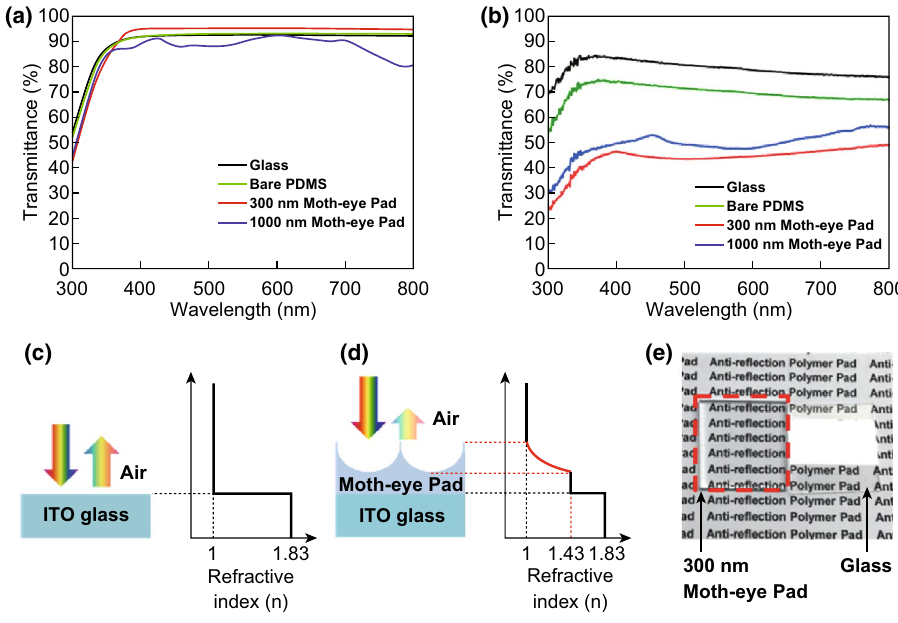
Fig. 3 a Transmittance and b reflectance spectra of the prepared samples. Schematic refractive index profiles of the c ITO/glass substrate and d moth‑eye PDMS film/ITO/glass substrate. e Digital camera image demonstrating the antireflective effect of the 300‑nm moth‑eye PDMS